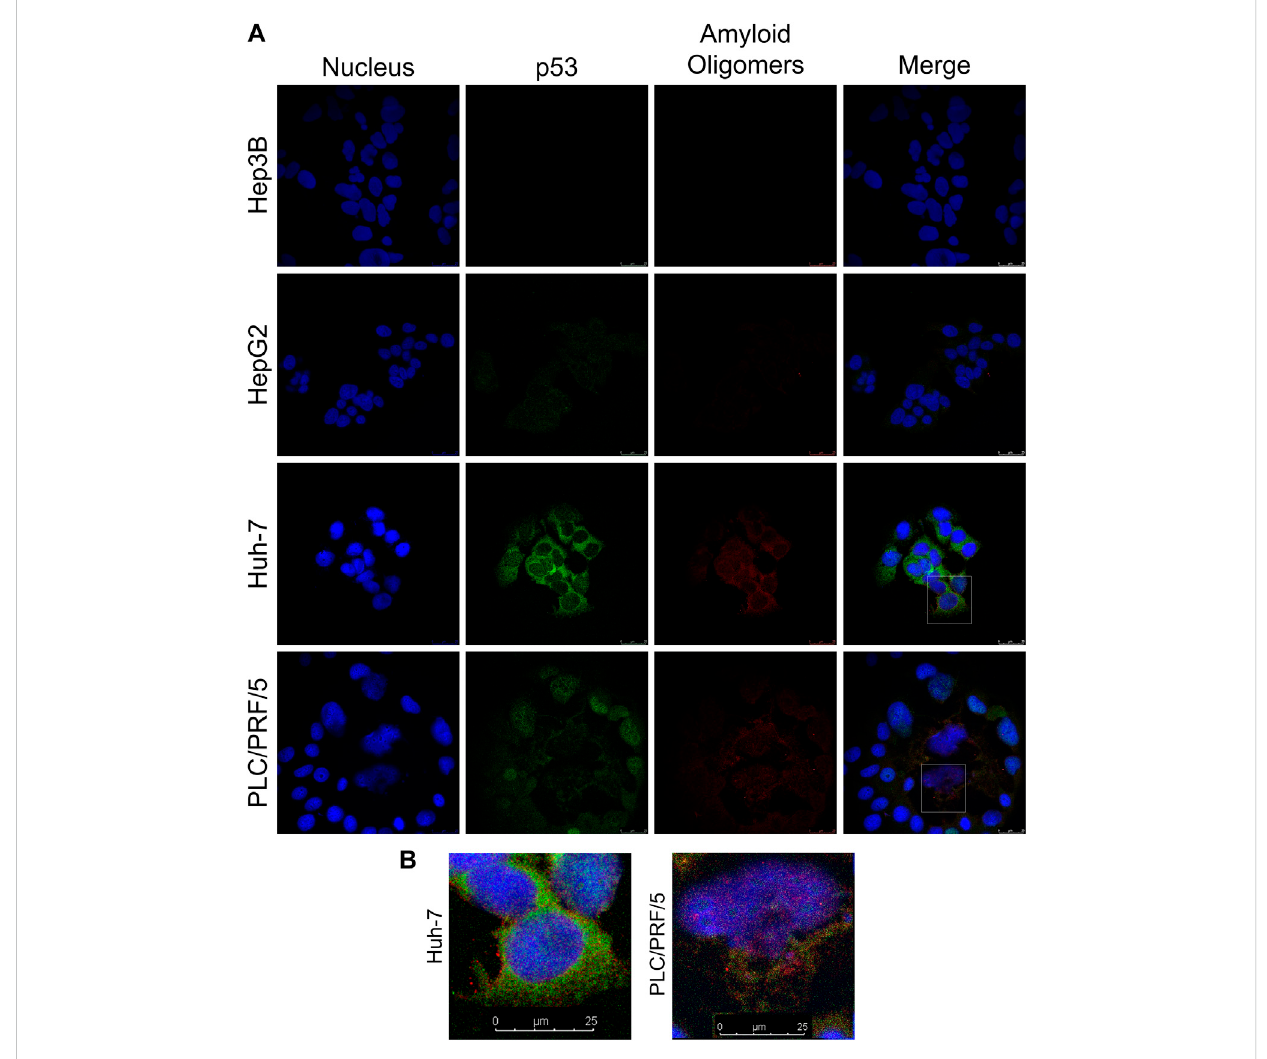
FIGURE 3 Intracellular colocalization of p53 amyloid oligomers in HCC cell lines. (A) Cells were labeled with anti-p53 (DO-1) and anti-oligomer (A11) antibodies, and the nuclei were stained with Hoechst. (B) Closer view of the highlighted regions in panel A of Huh-7 and PLC/PRF/5 with p53 amyloid oligomers (white arrow heads). Scale bars: 25